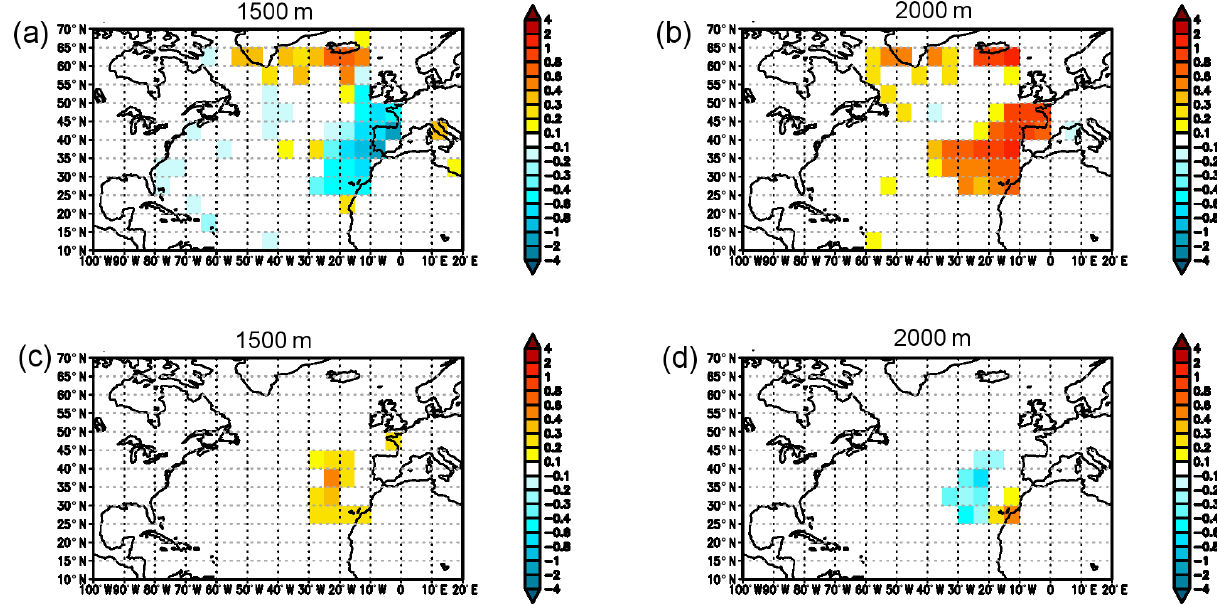
Figure 8. (a, b) PC-OFF mean temperature biases (K) with respect to observations at (a) 1500m and (b) 2000m; (c, d) PC-ON temperature departures (K) with respect to PC-OFF at (c) 1500m and (d) 2000m. Statistics are computed based on June data over the period 2005–2010, as well as after binning and averaging the observation-space departures over 5 ◦ × 5 ◦ latitude–longitude